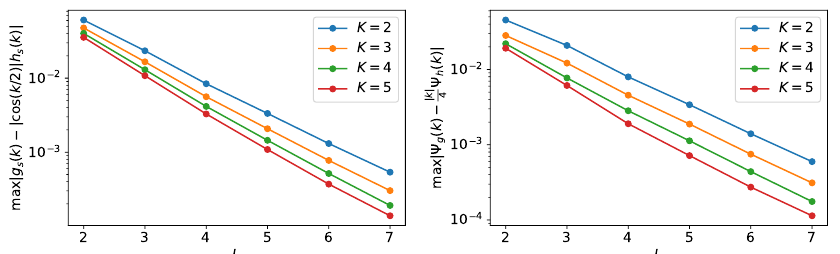
| g ( k ) − | sin ( k ) | h ( k ) | and k w w 2